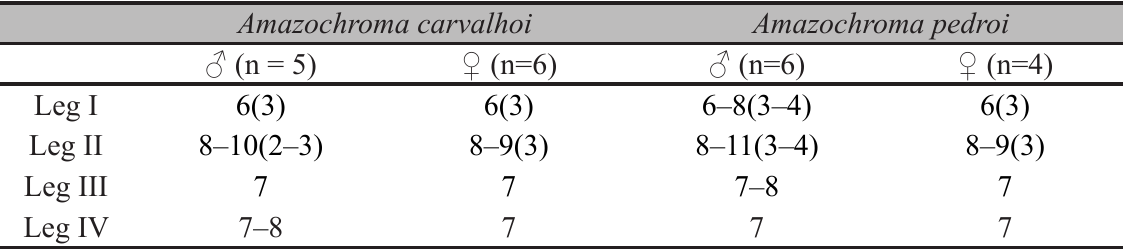
Table 4. Tarsal counts of Amazochroma carvalhoi (Mello-Leitão, 1941) comb. nov., ♂, holotype and other material examined and Amazochroma pedroi gen. et sp. nov., male holotype and